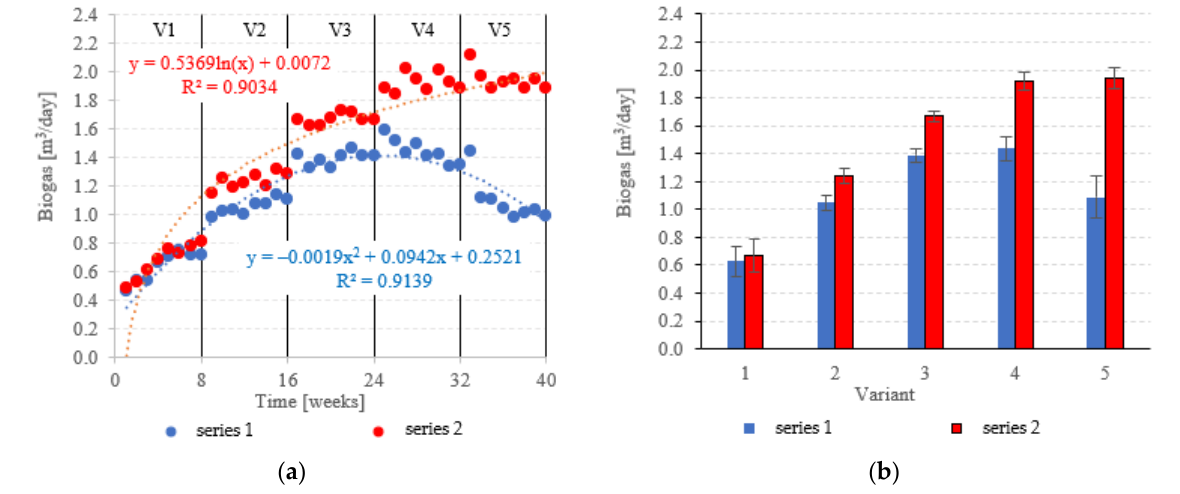
Figure 14. Biogas production (( a ) changes throughout the experiment; ( b ) average across experimental variants).